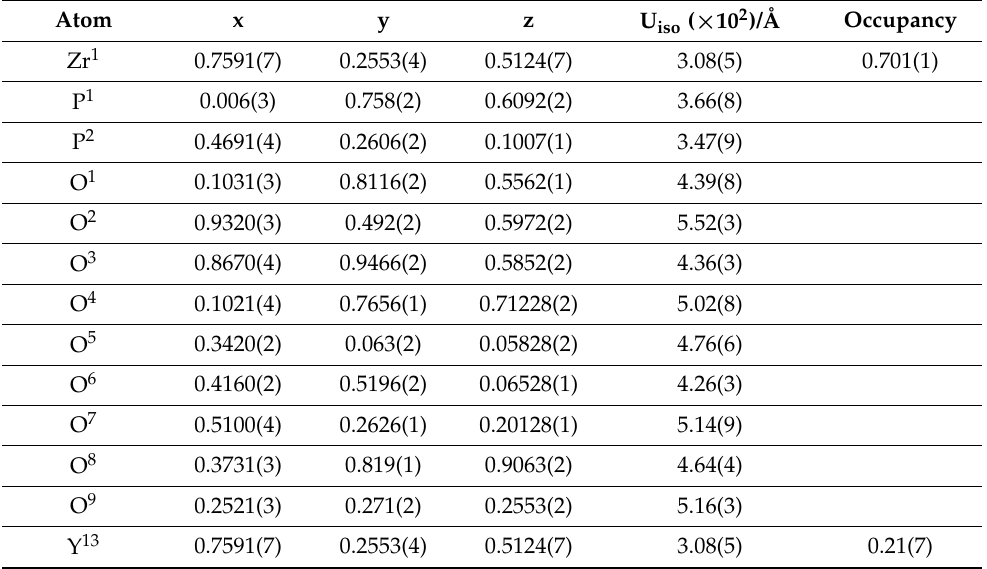
Table 5. Refined fractional atomic coordinates and isotropic thermal displacement parameters for conventionally refluxed 15% Y–ZrP.